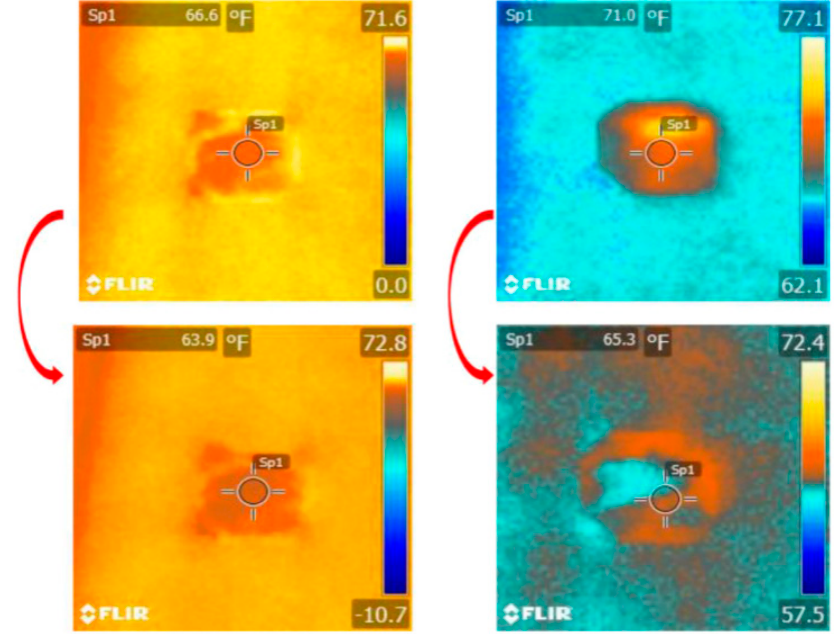
Figure 10. Impact of hotspot mitigation technique on the hotspot temperature distribution [115].